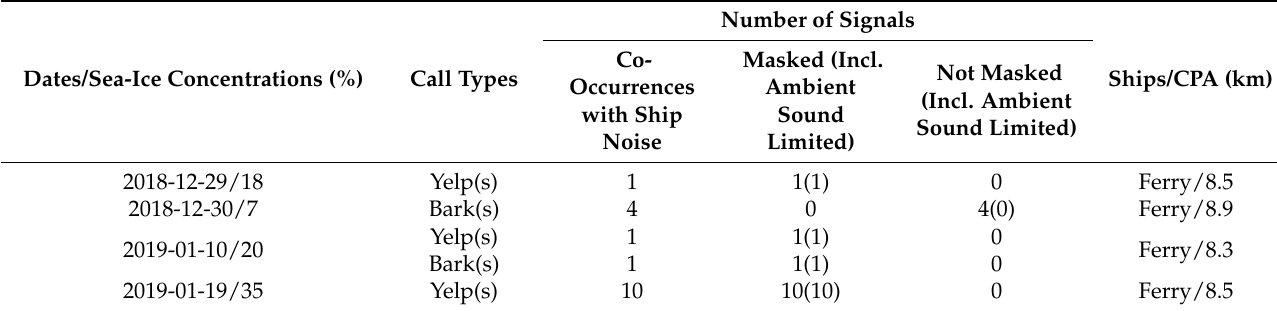
Table 2. Summary of the auditory masking analysis.